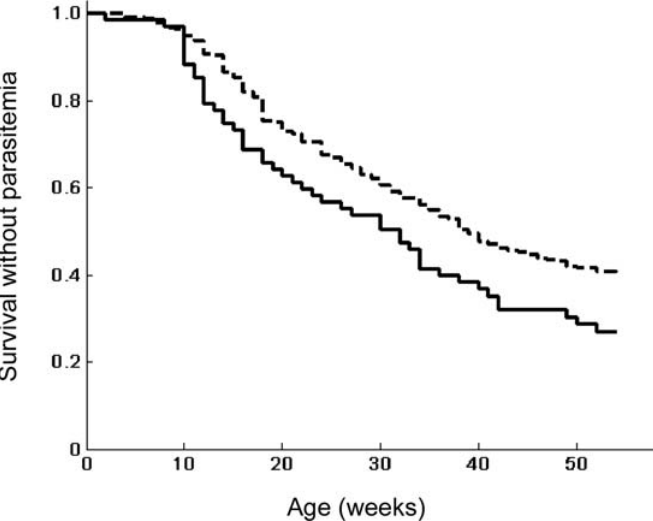
Figure 1. Kaplan-Meier Estimate of the Probability of Surviving without Parasitemia The graph shows the age at first parasitemia in offspring of PM-positive mothers (solid line) versus PM-negative mothers (dashed line). Infants born to PM-positive mothers experience their first parasitemia at a significantly younger age than infants of PM-negative mothers (log rank, p ¼ 0.02). DOI: